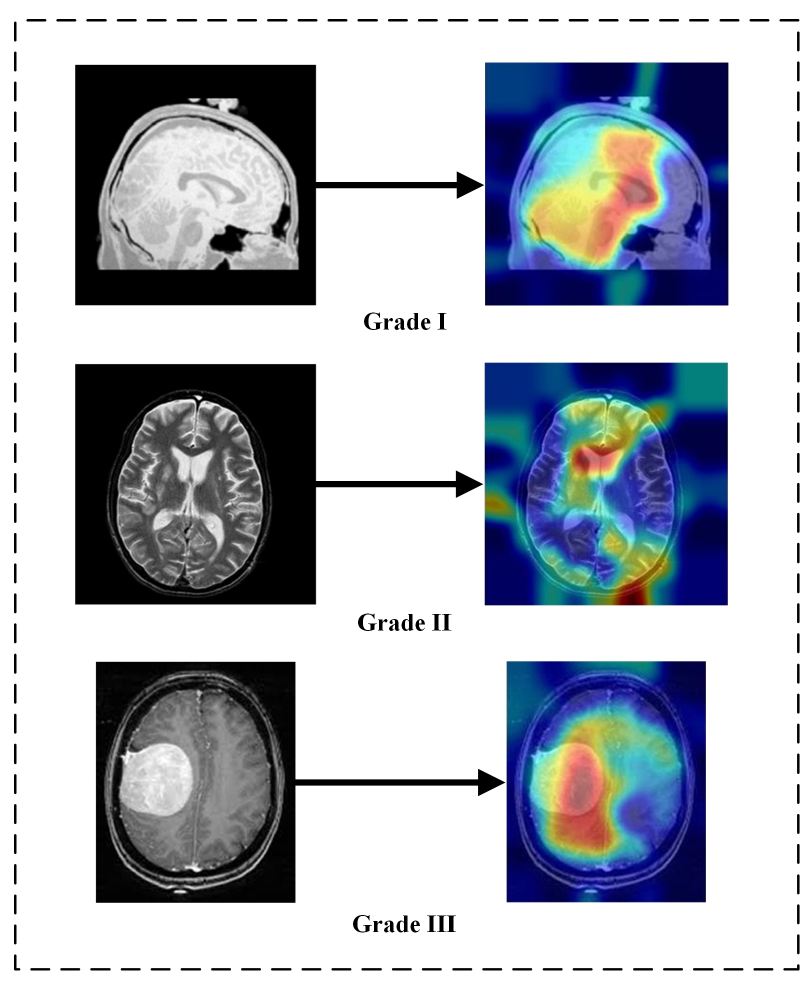
Figure 10. Localization of tumor using Grad-CAM on brain